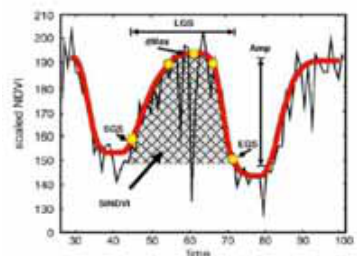
Figure 2. Crop phenology matrices estimated using the software TIMASAT- start of growing season (SGS), end of growing season (EGS), length of growing season (LGS), date of maximum NDVI (dMAX), Seasonal NDVI amplitude (AMP), and seasonally integrated NDVI (SiNDVI). (from Jonsson & Eklundh,